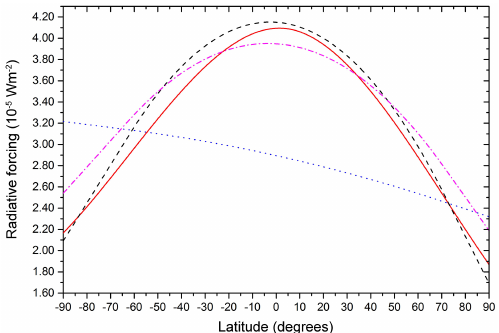
Figure 7. Variation of instantaneous radiative forcing for NF 3 (Wm − 2 ) with tropopause height for four profiles: thermal tropopause (red solid line), average thermal tropopause (black dashed line), temperature minimum tropopause (dash dot magenta line) and average temperature minimum tropopause (blue dotted